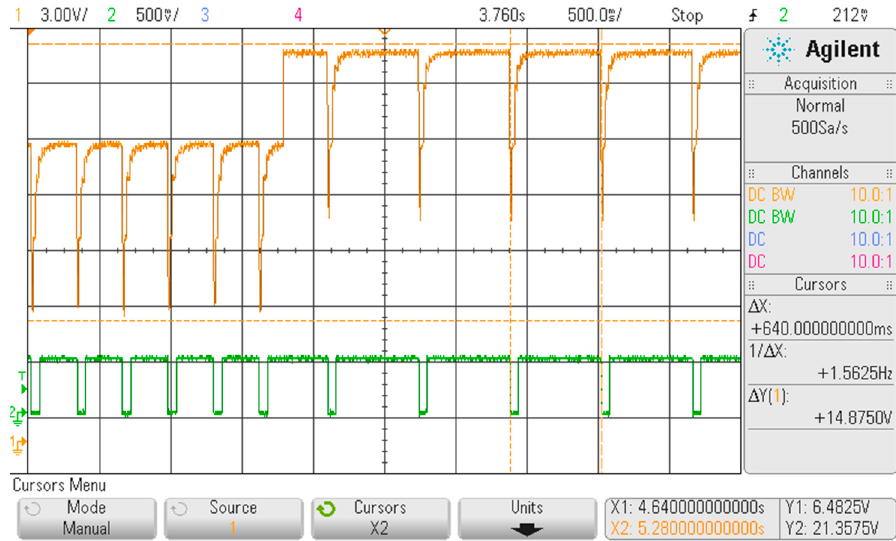
Figure 9. Displayed waveform on the oscilloscope with the FHRS switch in Position “0”. The yellow curve represents the signal measured on primary coil of relay at set on frequencies. The green curve shows signal measured on switched electrical part of relay, which is realized by mechanical contact of relay tab. Sensors 2020 , 20 , x FOR PEER REVIEW 11 of 15